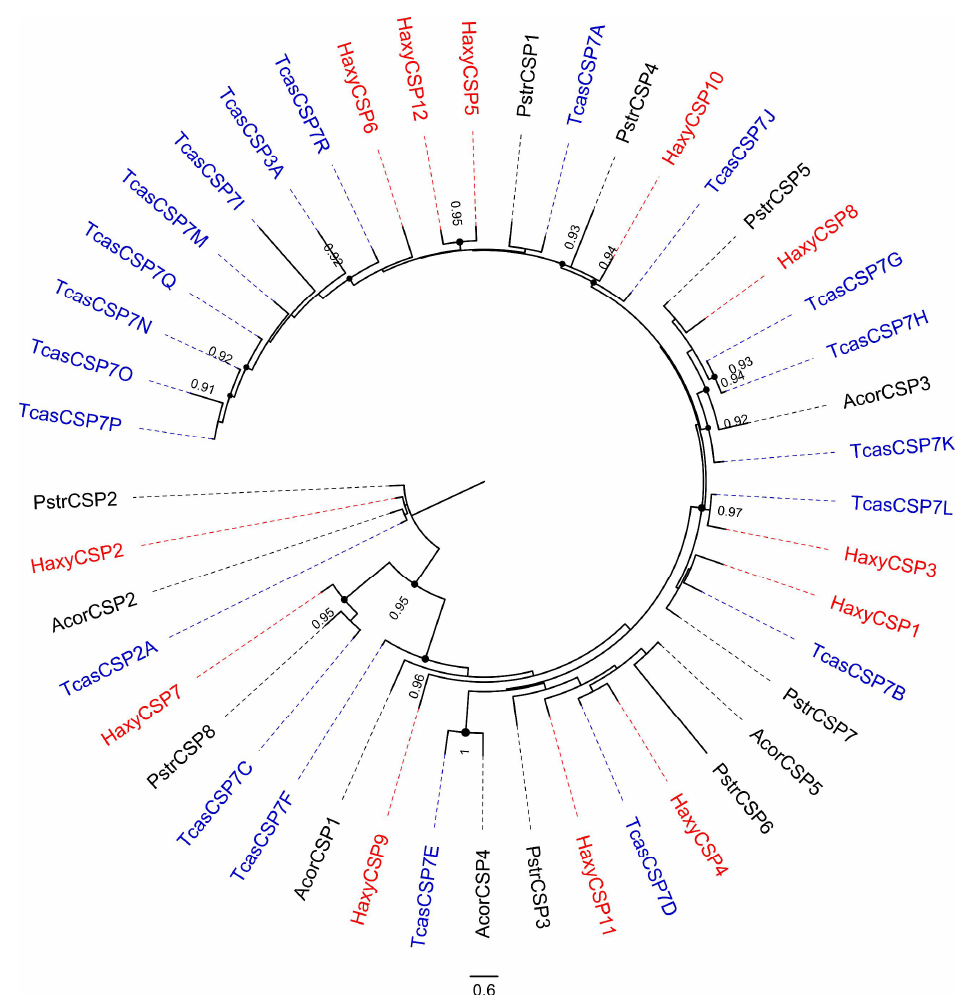
Figure 5. Phylogenetic tree of chemosensory proteins (CSPs). Red: Harmonia axyridis (Haxy); blue: Tribolium castaneum (Tcas); black: Anomala corpulenta (Acor) and Phyllotreta striolata (Pstr). Numbers and symbols at nodes represent support values higher than 0.9, where 1 represents maximal support.